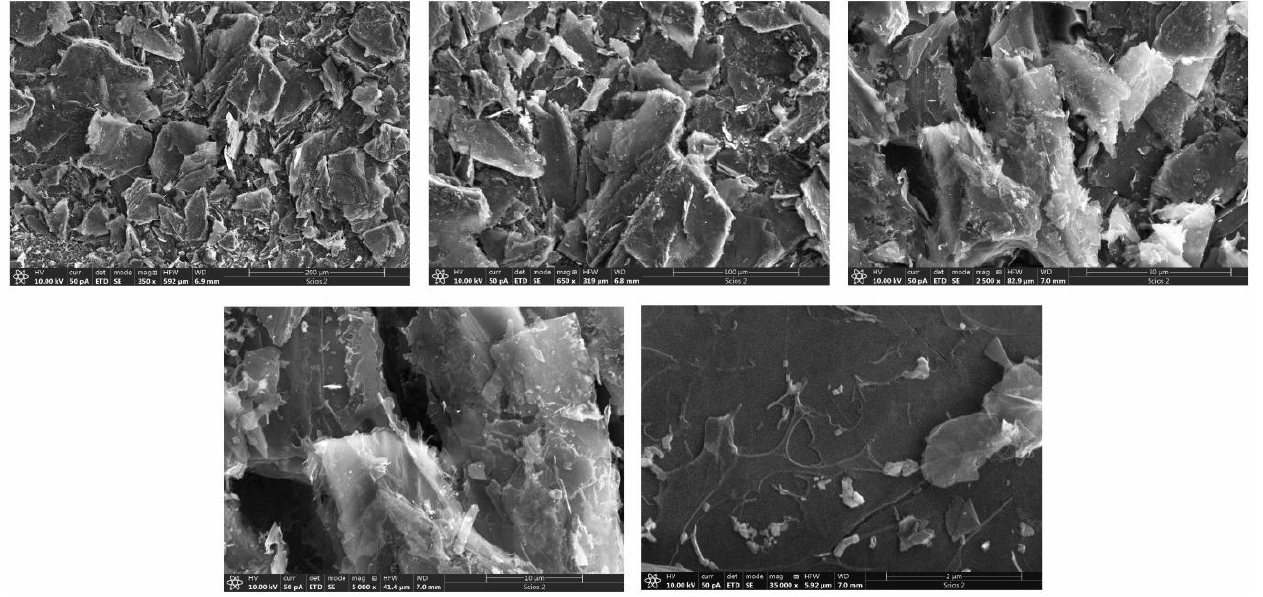
Figure 4. SEM micrographs of Mn 3 O 4 @N-doped carbon at five different magnifications (from 200 µm to 2 µm).